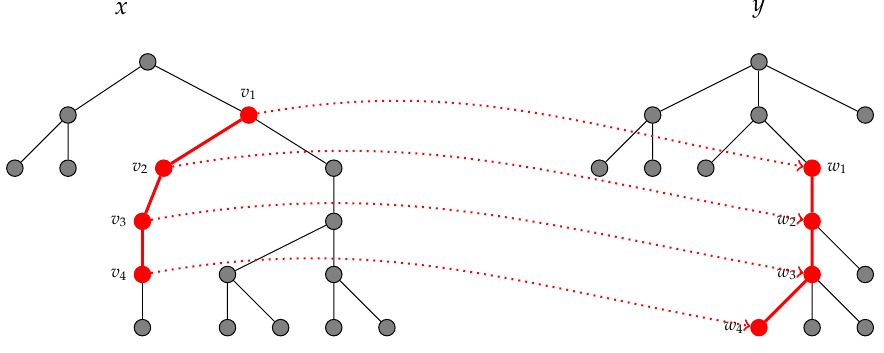
Figure 6. Subpaths and { ( v i , w i ) } i = 1,...,4 ∈ M SP x , y